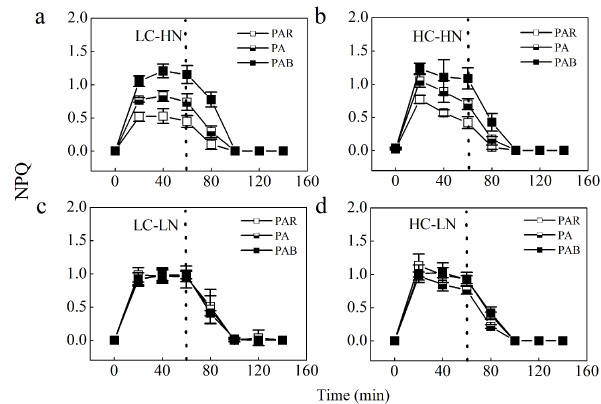
Figure 3. UV-induced inhibition of carbon fixation and PSII ac- tivity. UVA- and UVB-induced inhibition of (a, b) photosynthetic carbon fixation and (c, d) PSII of P. tricornutum cells grown at ambient (390µatm, LC) or elevated CO 2 (1000µatm, HC) under (a, c) NO − -replete (110µmolL − 1 , HN) and (b, d) NO − 3 (10µmolL − 1 , LN) conditions when exposed to PAR, PAR + UVA (PA) and PAR + UVA + UVB (PAB) for 60min, respectively. The irradiance intensity under solar simulator was the same as men- tioned above. Vertical bars are means ± SD, n = 3, the different let- ters indicate significant differences between different treatments at P< 0 . 05 level.